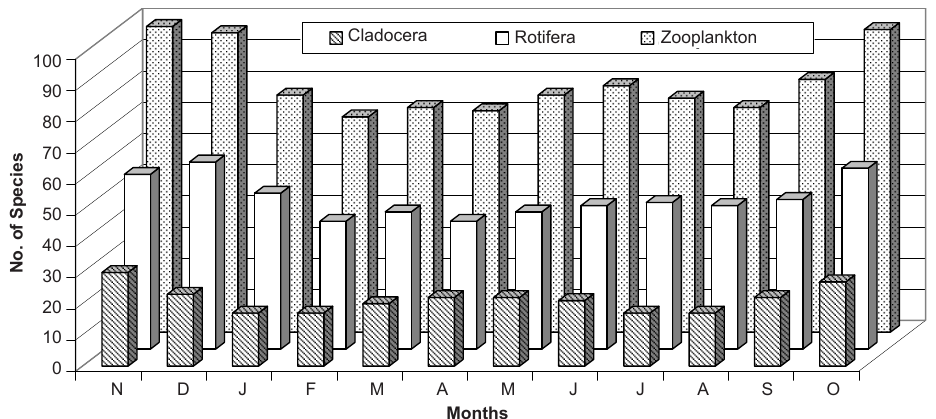
Figure 2. Monthly variations in richness of zooplankton, Rotifera and Cladocera (2003–04)